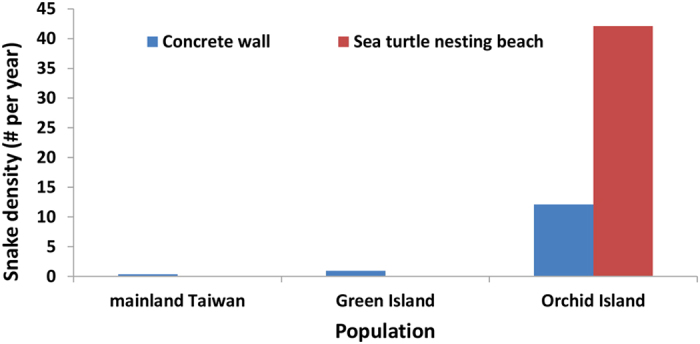
Snakes observed on concrete walls on Green island and Orchid Island when turtle eggs on Orchid Island are available (May–October) and not available (November–April) from 1997–2008.